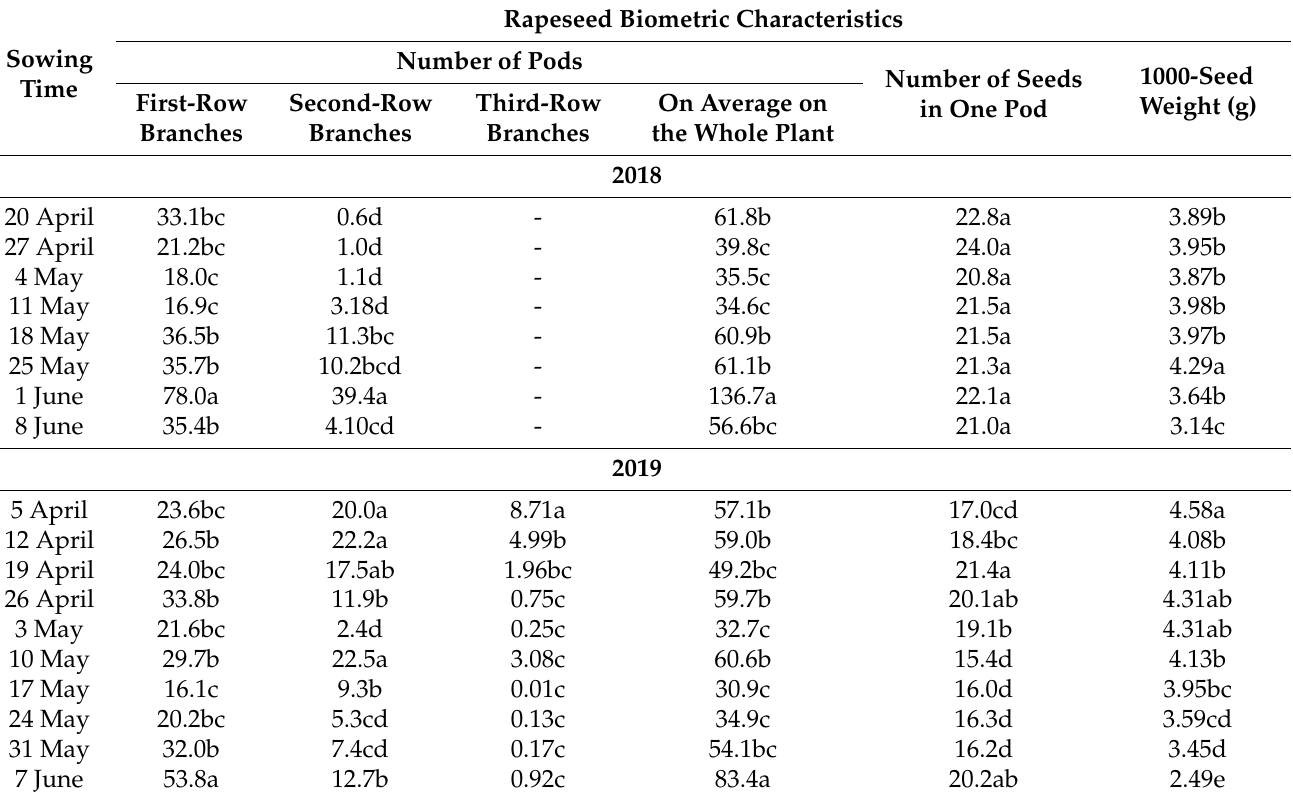
Table 4. Structure elements of productivity of spring rapeseed sown at different times in 2018–2019.